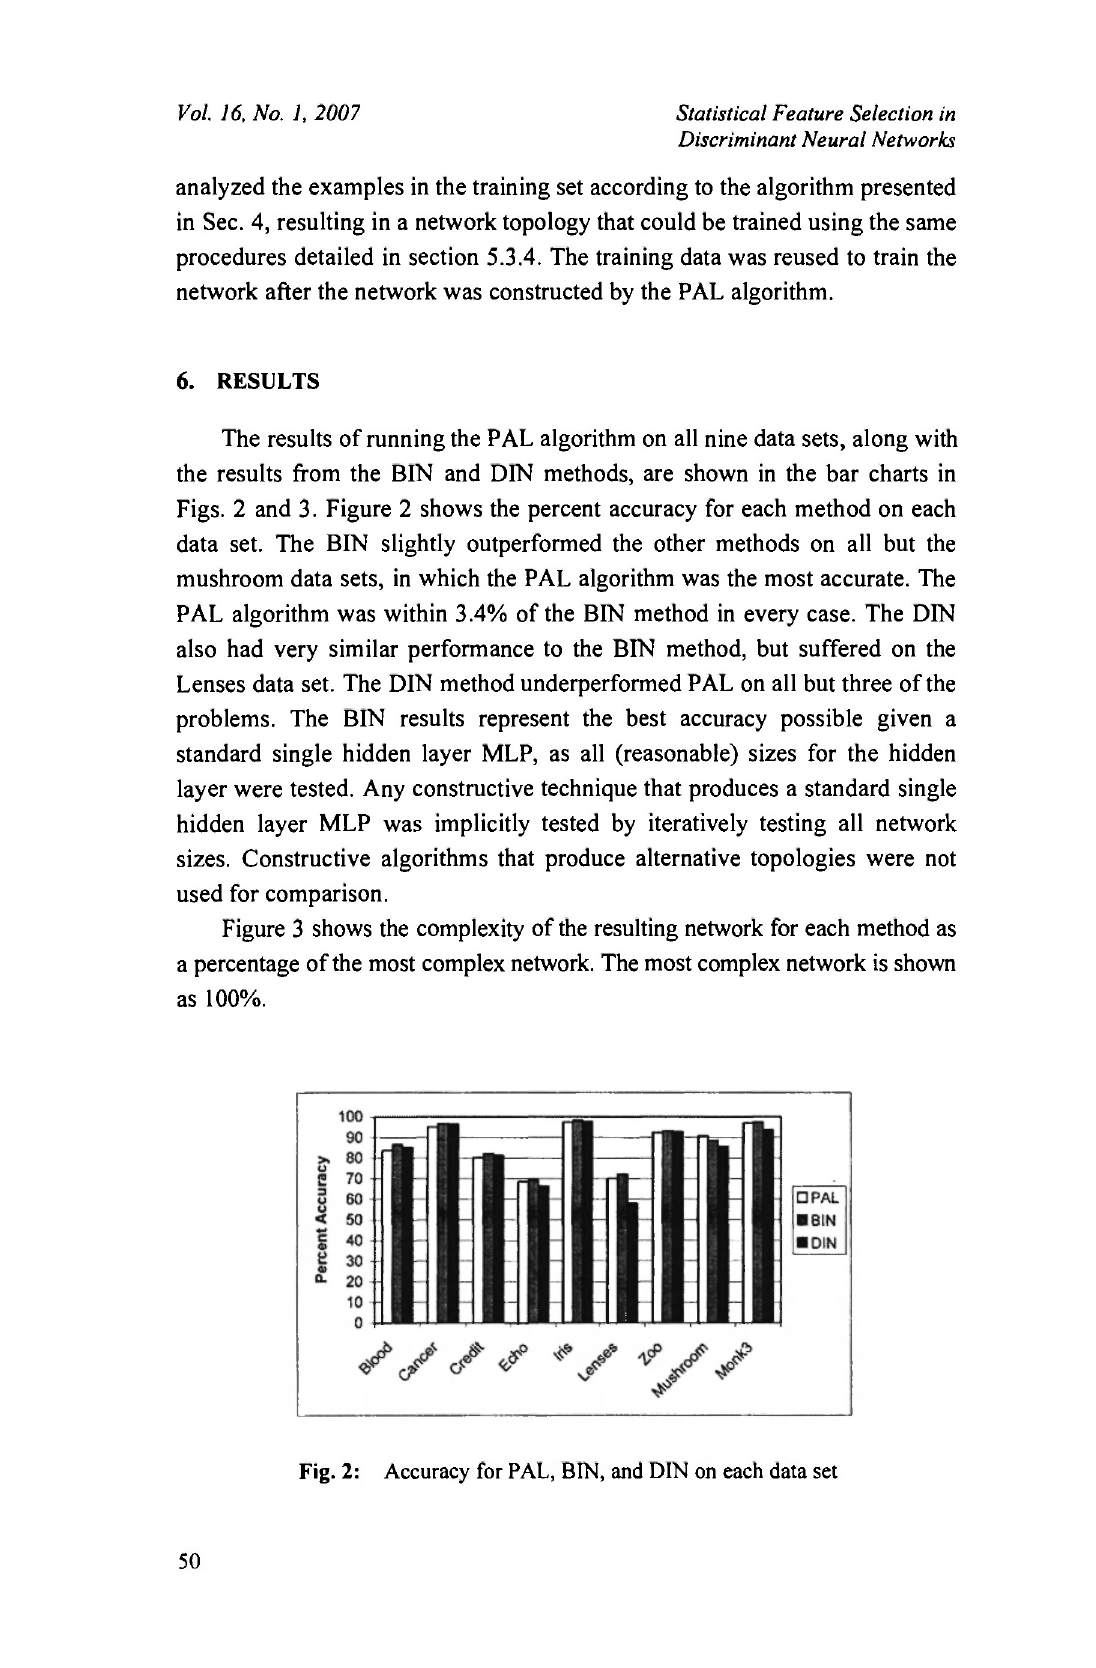
Fig. 2: Accuracy for PAL, ΒΓΝ, and DIN on each data